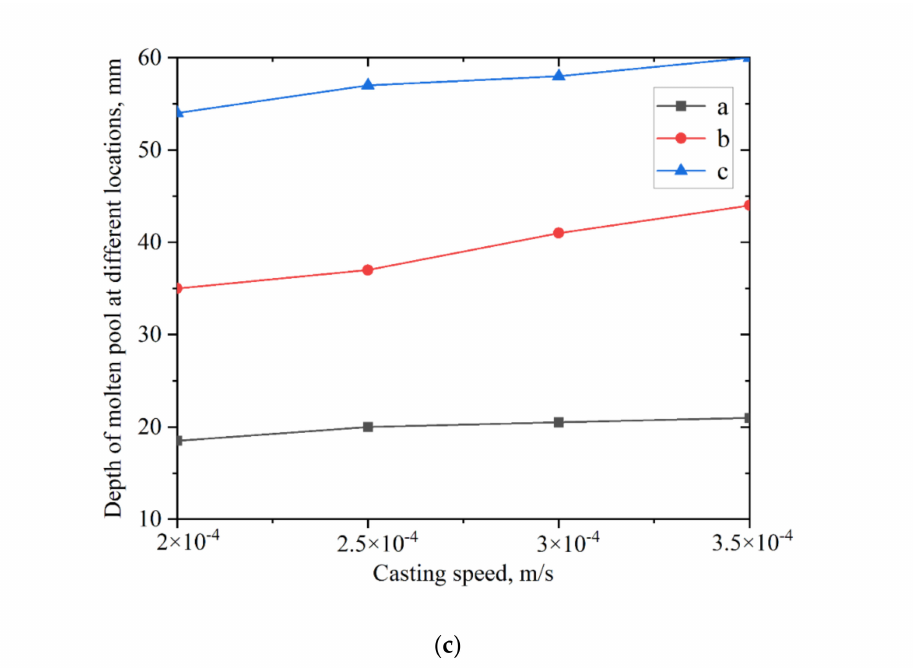
Figure 3. ( a ) Diagram of cold hearth for the pool surface, solid–liquid interface, and streamlines. ( b ) Contours of the solid–liquid interface at casting velocities of (1) 2 × 10 − 4 m/s, (2) 2.5 × 10 − 4 m/s, (3) 3 × 10 − 4 m/s, and (4) 3.5 × 10 − 4 m/s with a pouring temperature of 2273 K. Here, (a) is the deepest location below the inlet, (b) is the deepest location on the symmetry plane, and (c) is the deepest location on the outlet. ( c ) Depth of the molten pool at (a) the deepest location below the inlet, (b) the deepest location on the symmetry plane, and (c) the deepest location on the